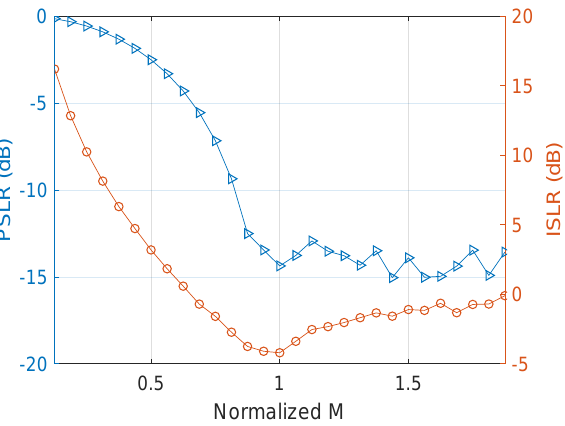
Figure 2. Comparison of the sidelobe performance of Costas DFC with different M under fixed pulse duration and